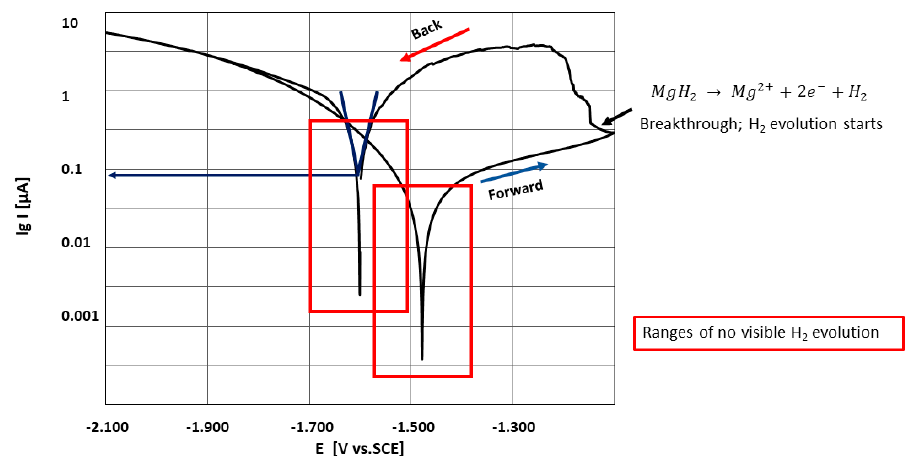
Figure 7. The principal shape of lgi vs. E curve. The red frames indicate the range where no hydrogen evolution was observed.